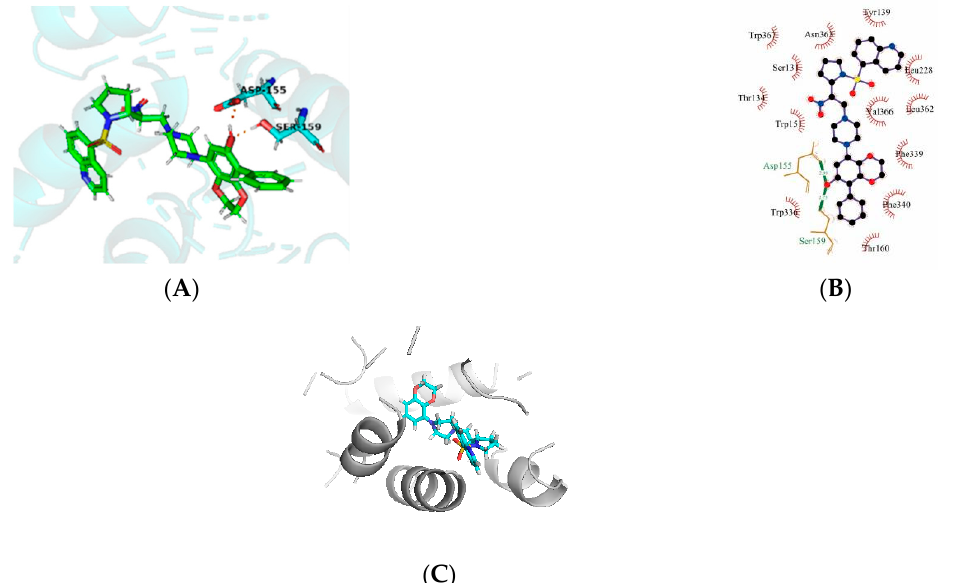
Figure 4. The molecular docking of newly designed compound 43k1 and compound 43 with protein 6A93. ( A ) and ( B ) are compound 43k1 interaction with protein, ( C ) is compound 43 with protein 6A93.